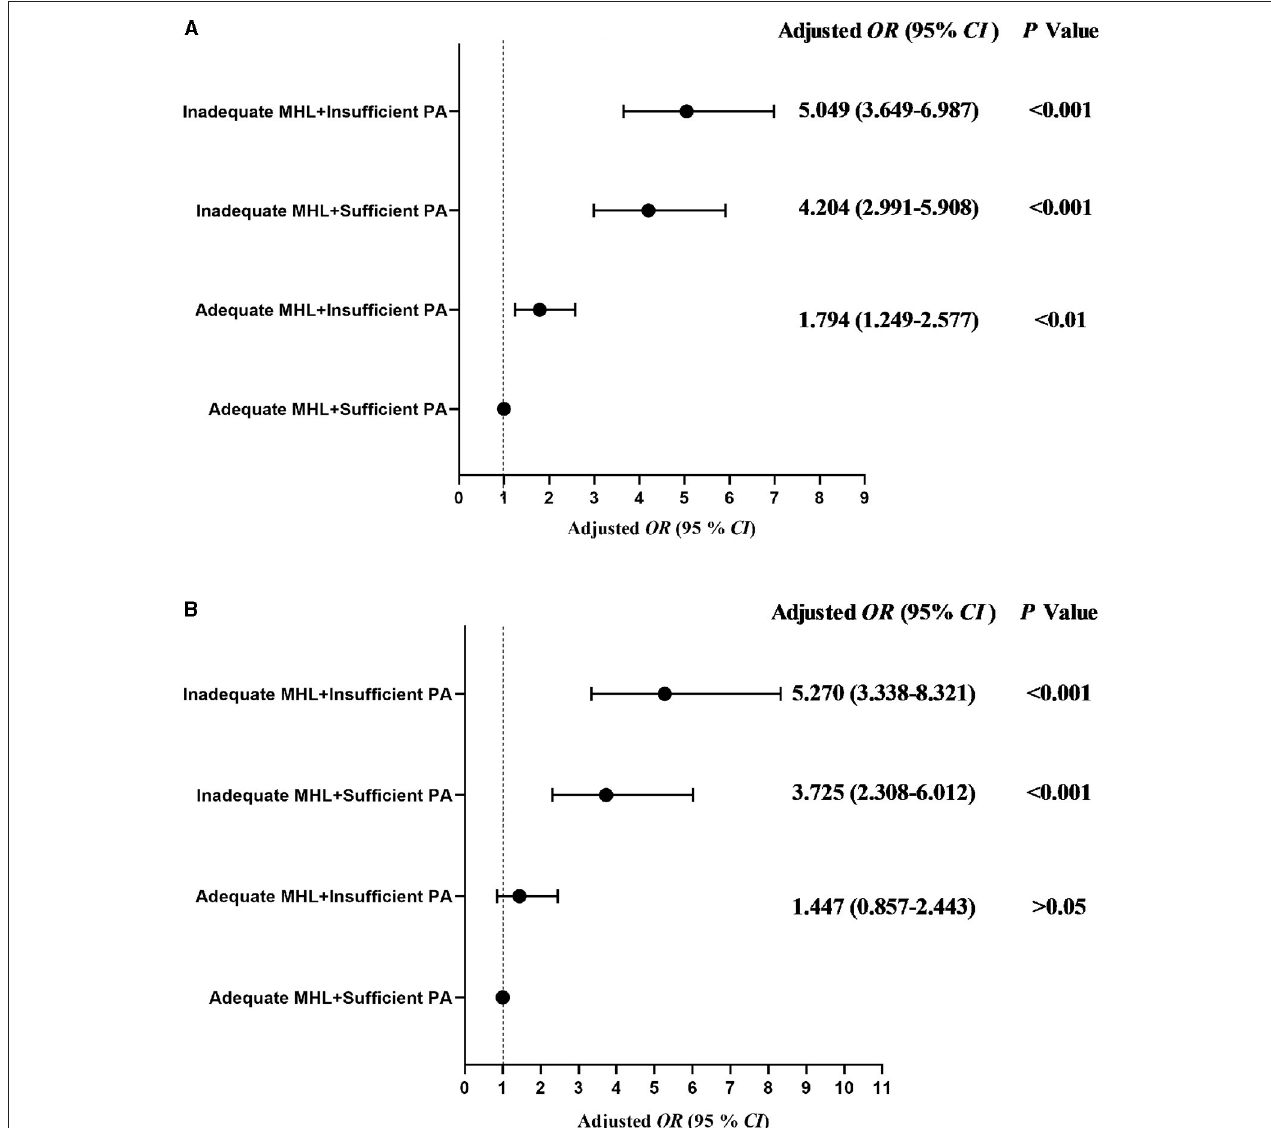
FIGURE 1 | Odds ratio (95% CI ) associated with the interactions of physical activity, mental health literacy, depressive symptoms and anxiety symptoms in college students. (A) Depressive symptoms, (B) Anxiety symptoms. MHL, mental health literacy; PA, physical activity; OR , odds ratio; CI , confidence interval. Adjusted for gender, grade, registered residence, parents’ educational level, self-reported family economy, cigarette use, alcohol